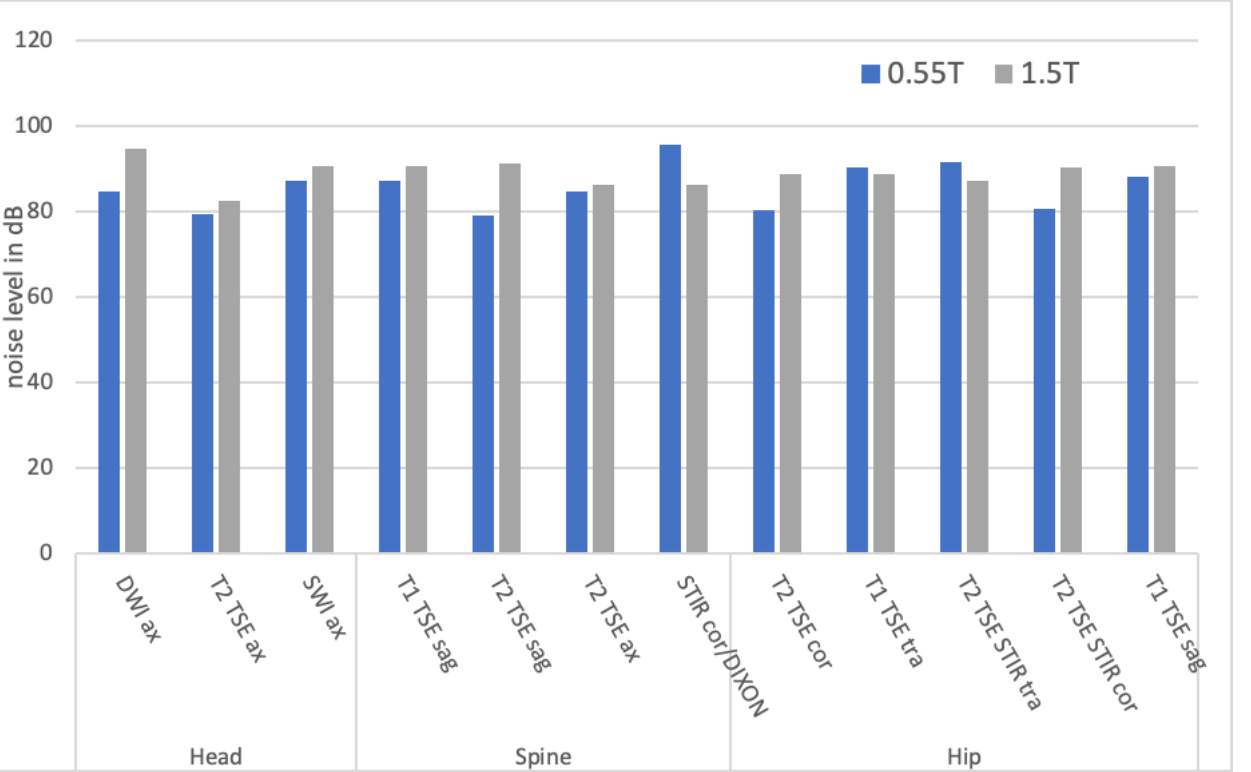
Figure 5. Maximum noise level in decibels (dB) for the individual sequences of the three body regions head, spine and hip.